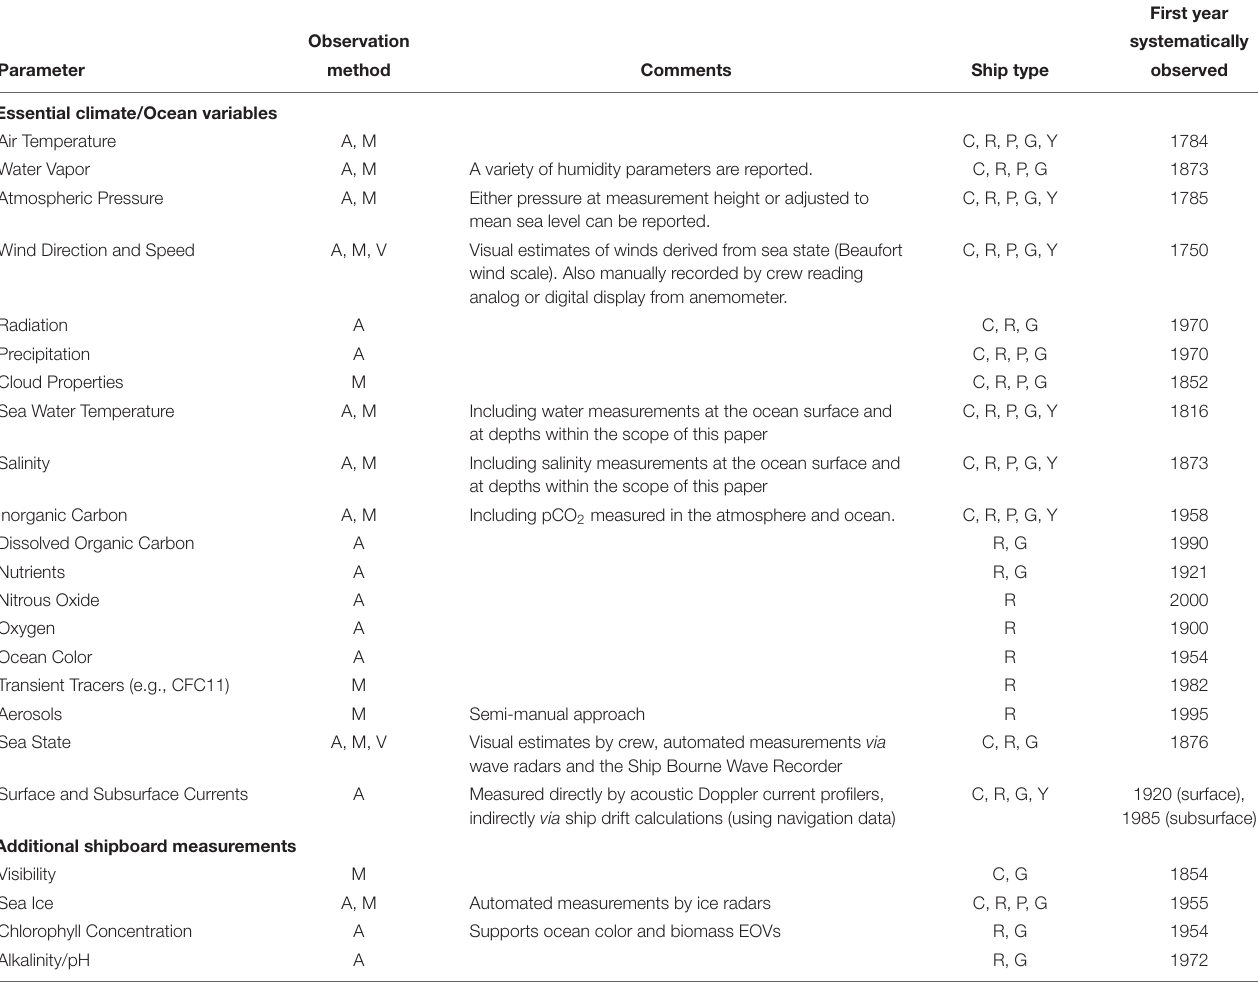
TABLE 1 | Parameters observed by ships near the ocean